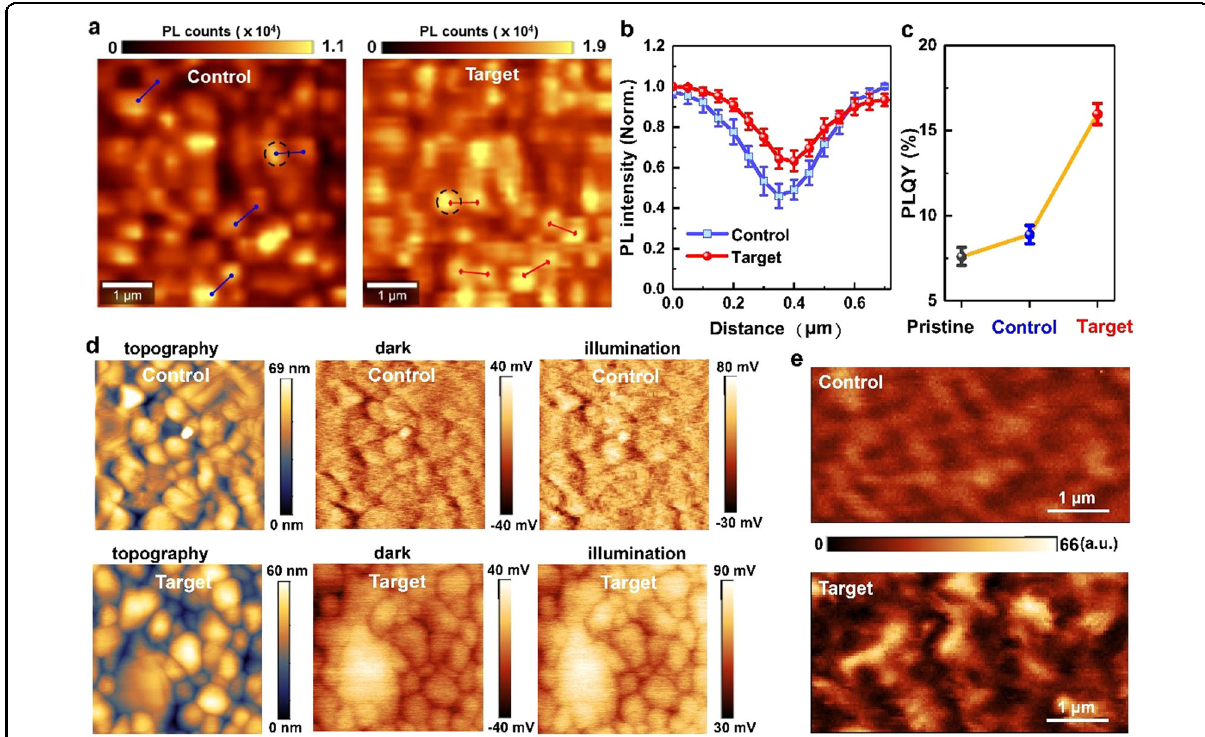
Fig. 3 Local changes in perovskite fi lms under illumination. a PL mappings of MAPbI 3 fi lms measured under 532 nm excitation. Control: PAT- treated MAPbI 3 . Target: Au@PAT-modi fi ed MAPbI 3 . b Normalized PL line scans across GBs of the control and target MAPbI 3 fi lms in an average of four random places (labeled in Fig. 3a). c PLQY of the pristine (black), control (blue), and target (red) MAPbI 3 fi lms in an average of fi ve samples of each type. d Topography and CPD spatial maps of control and target perovskite fi lms characterized by KPFM over an area of 4 µm 2 under illuminated and dark states. e SNOM optical images showing the near- fi eld distribution pro fi les of control and target perovskite fi lms, under illumination by a 532 nm